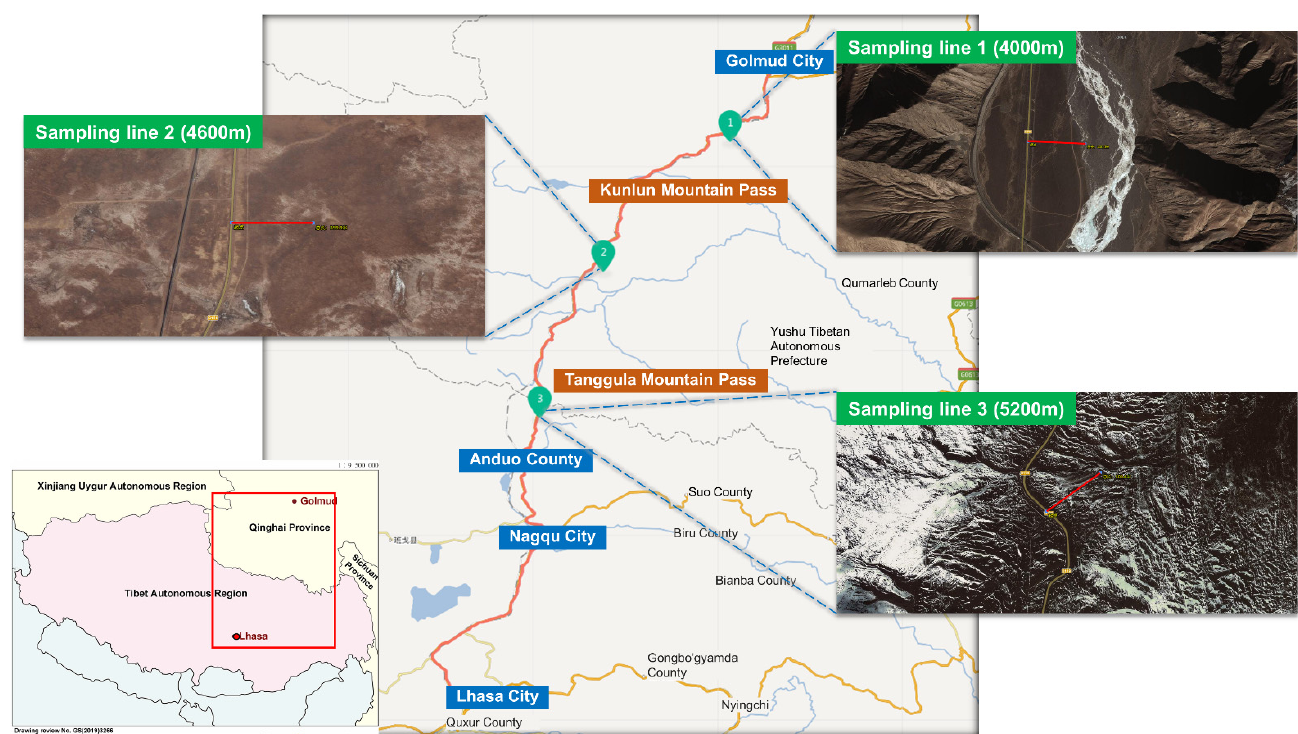
Figure 1. Sampling sites along the Qinghai–Tibet highway, China.